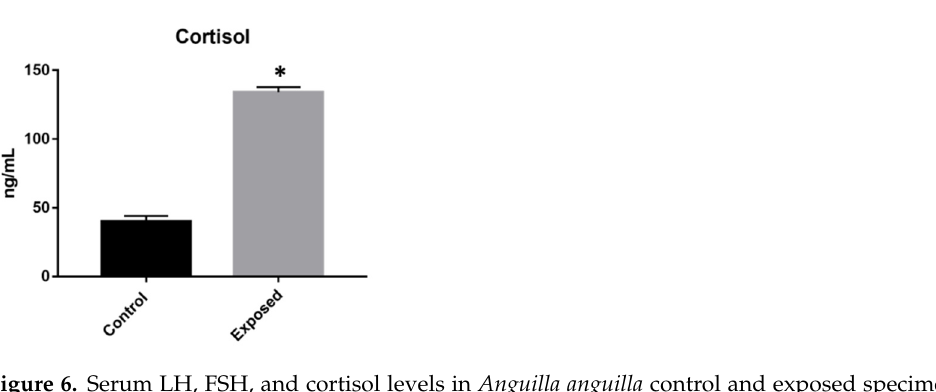
Figure 6. Serum LH, FSH, and cortisol levels in Anguilla anguilla control and exposed specimens. Cocaine exposure decreased LH and FSH levels and increased cortisol levels. Values are means ± SD of the mean. (*) serum significantly different ( p < 0.05) from the control values.